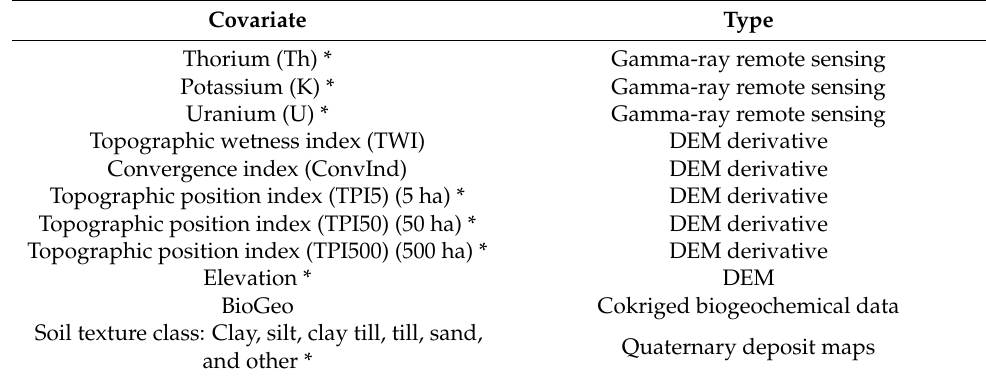
Table 2. Covariates from airborne gamma ray data, topographical data (digital elevation model, DEM), quaternary deposit maps, and biogeochemical data used in the digital soil mapping (DSM) model. Data on covariates marked with an asterisk (*) were prepared for the study by Piikki and Söderström [35]. Each soil class was converted to a separate covariate using one-hot encoding. Covariate Type Thorium (Th) * Gamma-ray remote sensing Potassium (K) * Gamma-ray remote sensing Uranium (U) * Gamma-ray remote sensing Topographic wetness index (TWI) DEM derivative Convergence index (ConvInd) DEM derivative Topographic position index (TPI5) (5 ha) * DEM derivative Topographic position index (TPI50) (50 ha) * DEM derivative Topographic position index (TPI500) (500 ha) * DEM derivative Elevation * DEM BioGeo Cokriged biogeochemical data Soil texture class: Clay, silt, clay till, till, sand, Quaternary deposit and other *